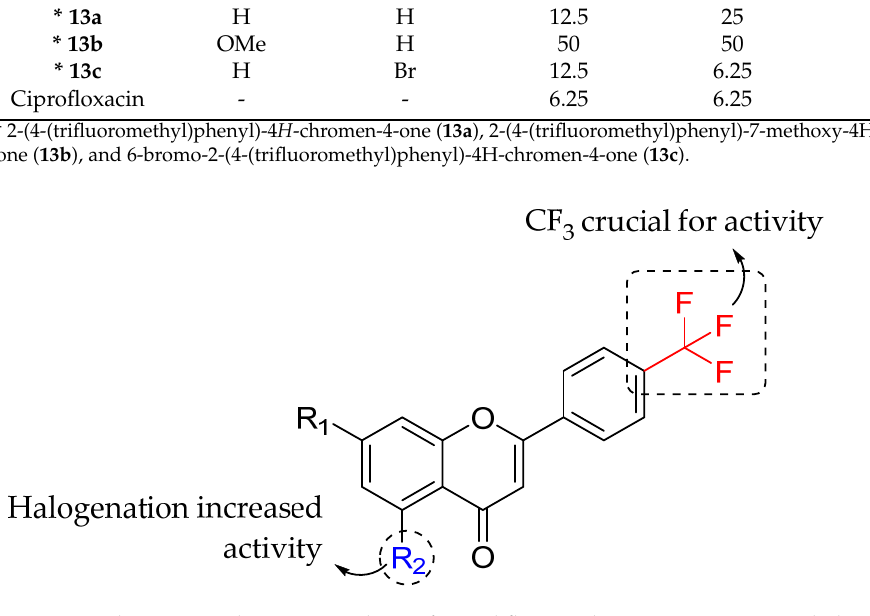
Table 22. Antibacterial activity of flavone derivatives against B. subtitlis , S. aureus , and P. aeruginosa . Com. No.